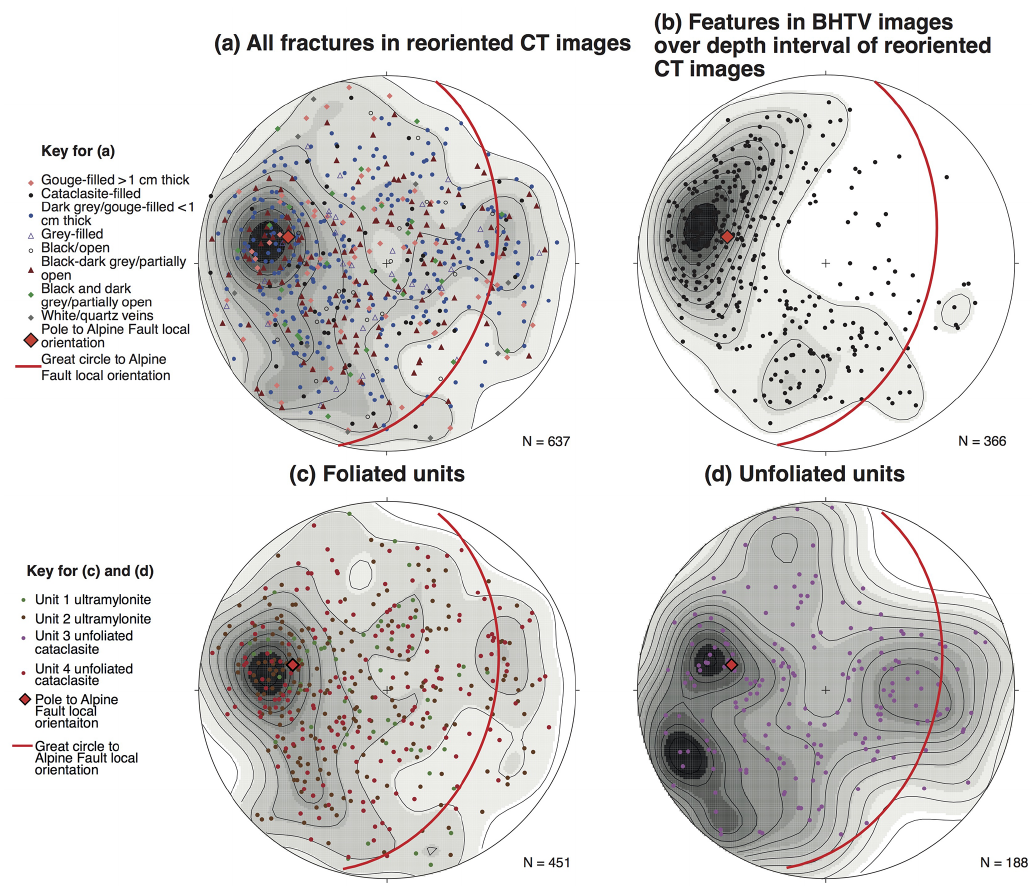
Figure 5. Lower hemisphere equal area stereoplots depicting orientation of fractures in DFDP-1. Contouring on stereoplots was applied to poles that are weighted depending on their orientation correction w (see Sect. 3.2) and that are rounded to the nearest whole number. Contours were then generated for the weighted poles using a probability distribution calculated by a Kernel function in the RFOC package for R (Lees, 2014). Great circle represents orientation of Alpine Fault plane and foliation at DFDP-1 site (Townend et al., 2013). (a) Orientation of all fractures that were reoriented by matching structures between unrolled CT images and BHTV images, sorted by fracture type (Williams et al., 2016). (b) Orientation of features recognised in the BHTV images over the interval of reoriented core (94–126m in DFDP-1B). Fracture orientations extracted from reoriented DFDP-1 CT images in (c) foliated units and (d) unfoliated units, using the DFDP-1 lithological classification scheme (Toy et al., 2015).